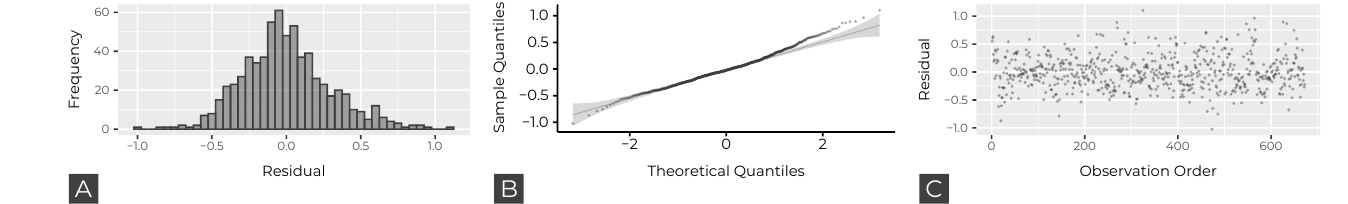
Figure A4. Normal distribution of residuals shown in ( A ) histogram and ( B ) QQ-Plot. Additionally scatterplot in ( C ) shows that there is no major correlation between the residuals.